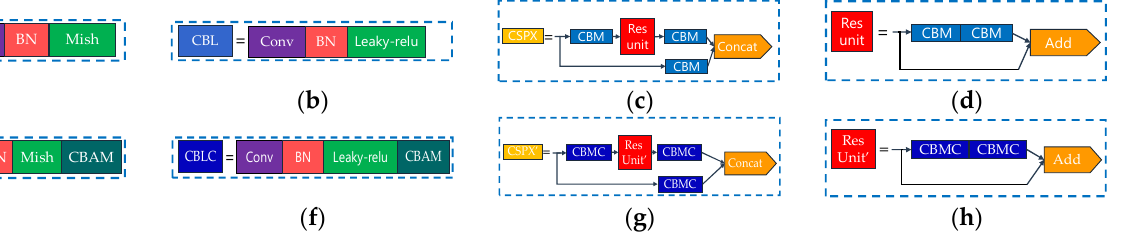
Figure 6. The original module and the improved module. ( a ) CBM module. ( b ) CBL module. ( c ) CSP module. ( d ) Resunit module. ( e ) CBMC module. ( f ) CBML module. ( g ) CSPX’ module. ( h ) Resunit’ module.